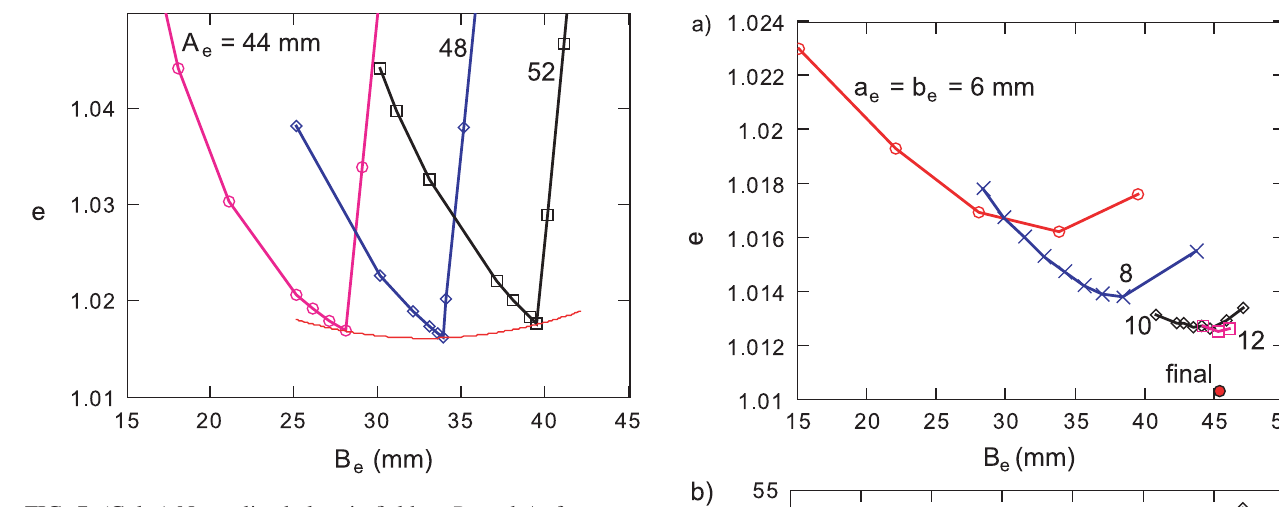
FIG. 7. (Color) Normalized electric field vs B ¼ 6 mm b e